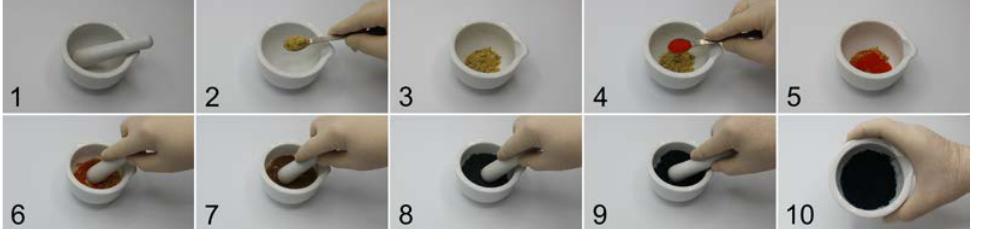
Figure 4. Mechanochemical preparation of Prussian blue from ferrous sulfate and potassium hexacyanoferrate(III).